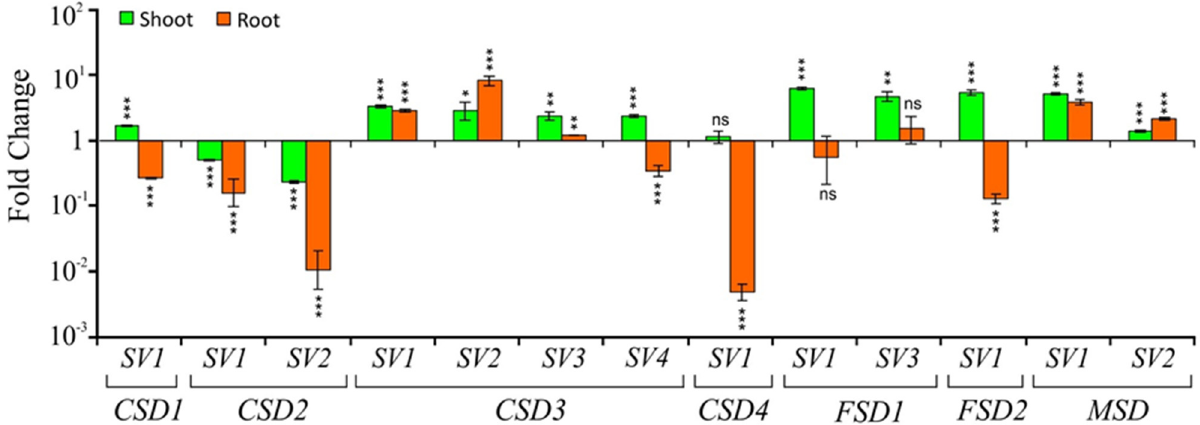
Figure 7. Relative transcript levels (on Y -axis) of CSDs , FSDs , and MSD splice variants (indicated by numbers on X -axis) in response to copper deficiency, in shoot and root tissue after 24 h of the stress treatment. For normalization and statistical analysis, see figure legend 3.